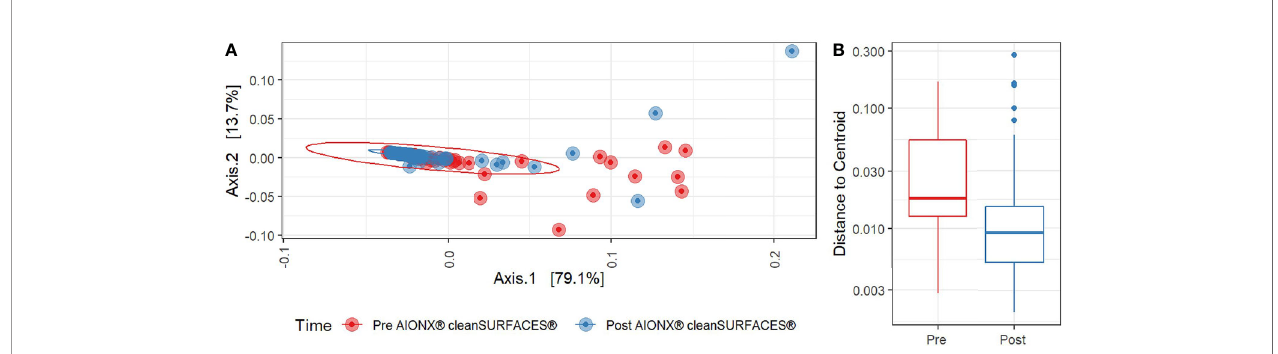
FIGURE 4 | (A) Principal Coordinates Analysis (PCoA) plot of weighted Jaccard distances reveals signi fi cant differences [PERMANOVA, p=0.005] in global microbial transcriptional pro fi les between samples collected before (Red) and after (Blue) the intervention of the AIONX ® cleanSURFACES ® . (B) . Boxplot comparing within- group dispersion between samples collected before (Red) and after (Blue) AIONX ® cleanSURFACE ®